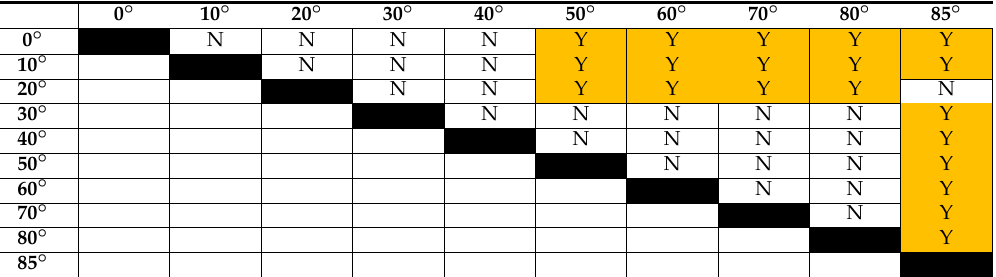
Table 3. Comparison of means differences between angles using Student's t -test ( t -test). Use of contrasts to determine whether there is a significant difference ( p ≤